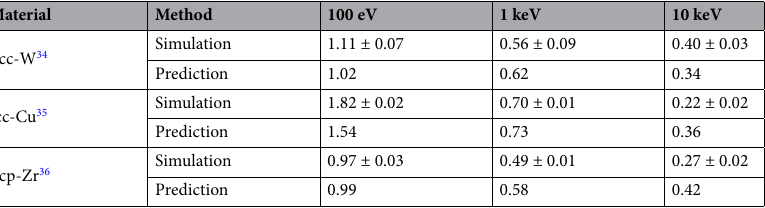
Table 1. Saturated vacancy content in at.% for three types of crystal structures damaged by cascades with given recoil energy. Comparison between prediction (8) and simulation in the high dose limit shows that the model qualitatively reproduces the drop in vacancy content as the recoil energy